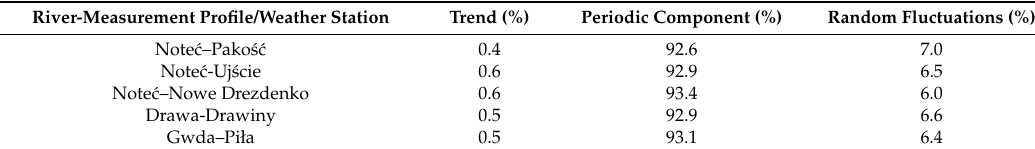
Table 3. The decomposition of daily water and air temperature time series into additive components.